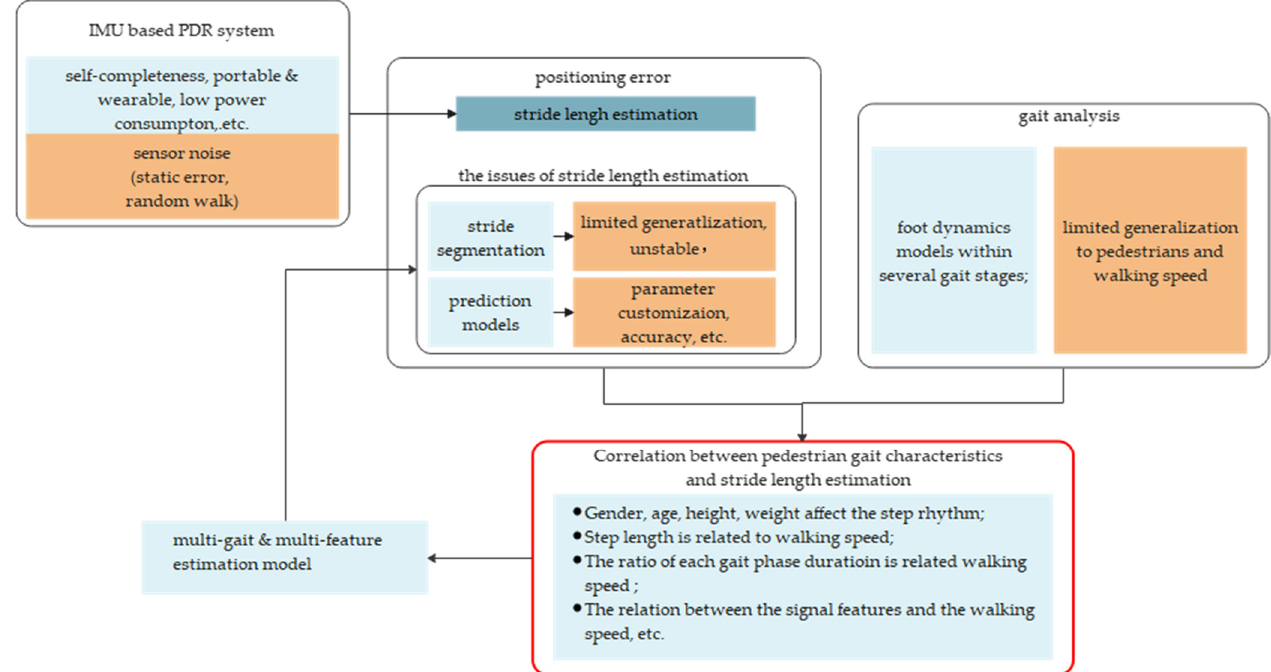
Figure 2. The overall idea of this article.